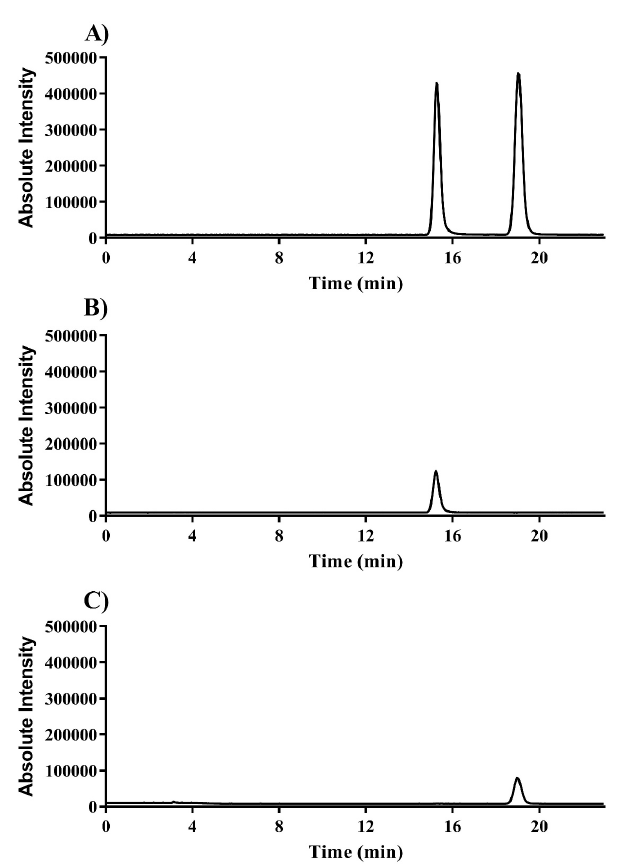
FIGURE 2 – (A) Chromatogram obtained after analyzing spironolactone and canrenone (5.0 µg mL −1 ) in the ion mode selected for the ion in common ( m/z = 341.1); (B) chromatogram of the spironolactone fragment ( m/z = 439.0) with a retention time of 15.8 min; and (C) chromatogram of the canrenone fragment ( m/z 363.1) with a retention time of 19.8